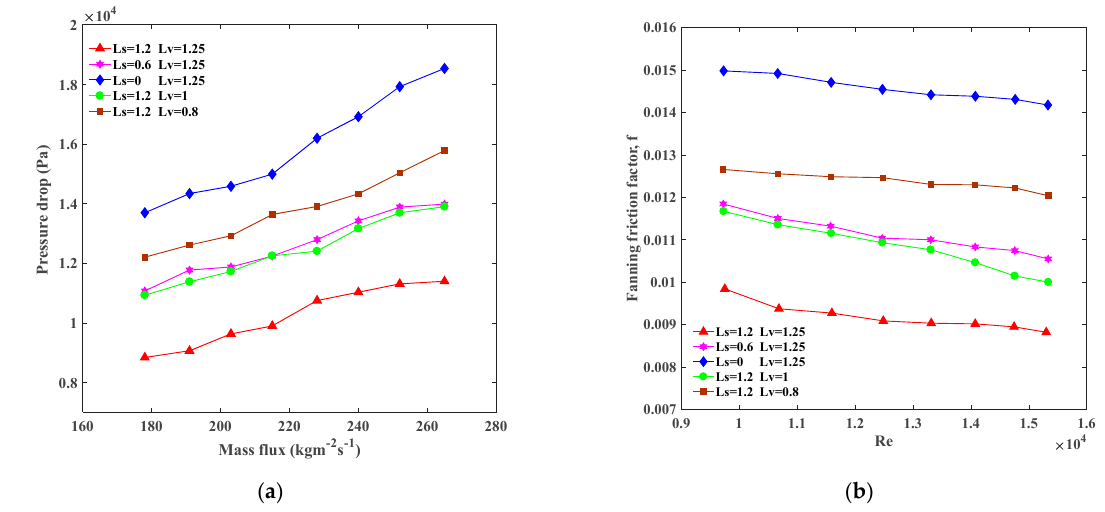
Figure 10. The overall pressure drop versus mass flux and overall Fanning friction factor versus Re for different fin arrangements: ( a ) overall pressure drop versus mass flux; ( b ) overall Fanning friction factor versus Re.